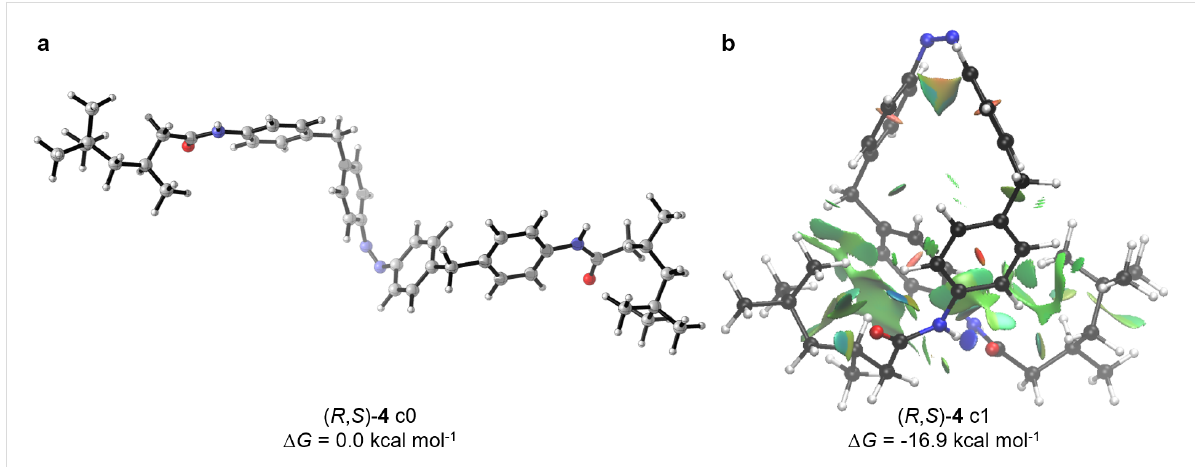
Figure 1: a) Optimized geometry of open conformer ( R , S )- 4 c0. b) NCI plot of the most stable conformer of ( R , S )- 4 (green and blue isosurfaces indi- cate attractive noncovalent